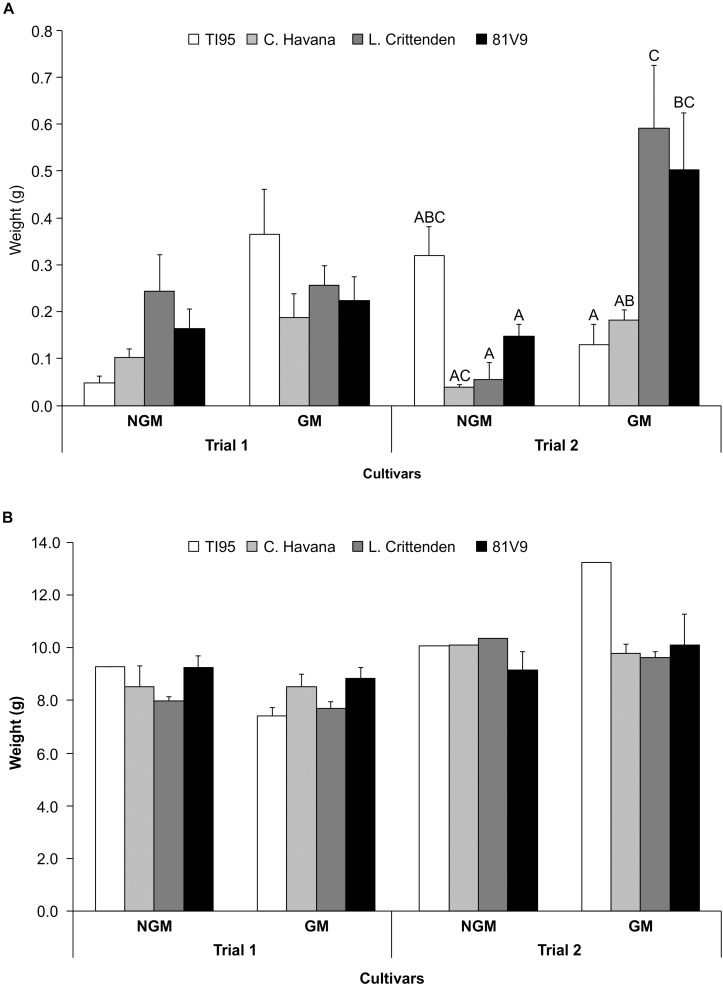
PFA has no effect on final tobacco hornworm weight in field conditions. Mean larval weight ± S.E. on field-grown tobacco (N = 20 larvae/cultivar) in two field trials. (A) 7 days hornworm larval weight and (B) pre-pupal larval weight (after approximately 20 days). Bars with the same letter in (A) trial 2 are not statistically different, no letters in (A) trial 1 and in (B) trials 1 and 2 indicates no statistical difference among all treatments (2-way ANOVA, Tukey’s pairwise comparison, P > 0.05).